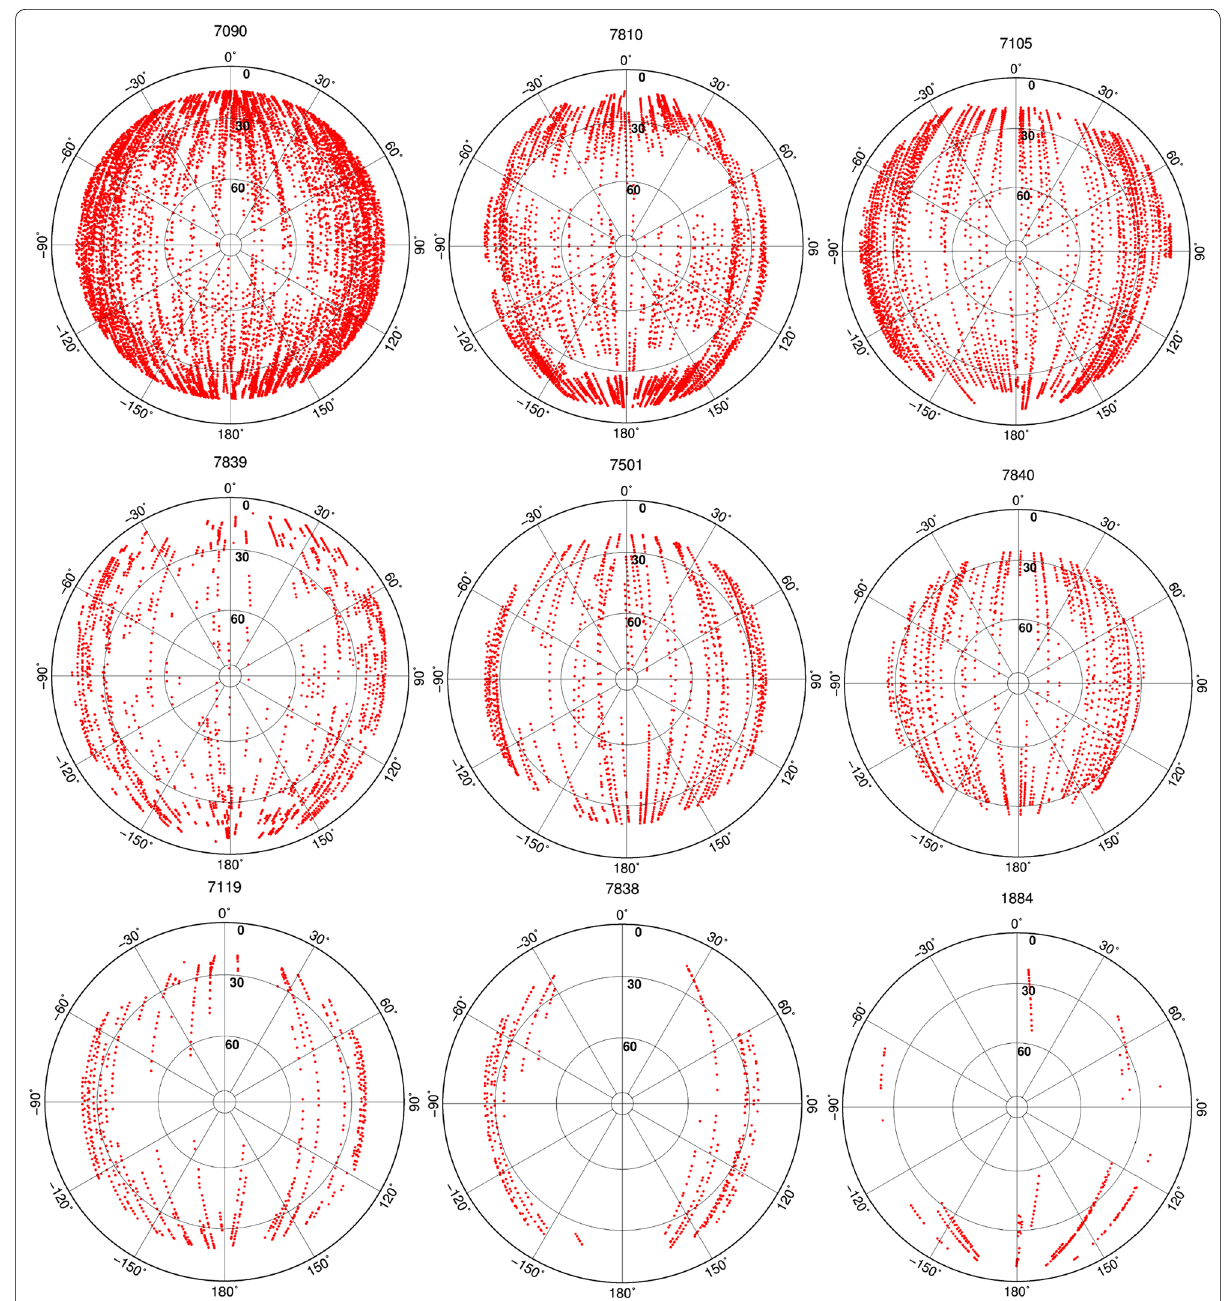
Fig. 6 SLR observation distribution of the GRACE-A taken by SLR sites seen in the station-fixed system (azimuth and elevation